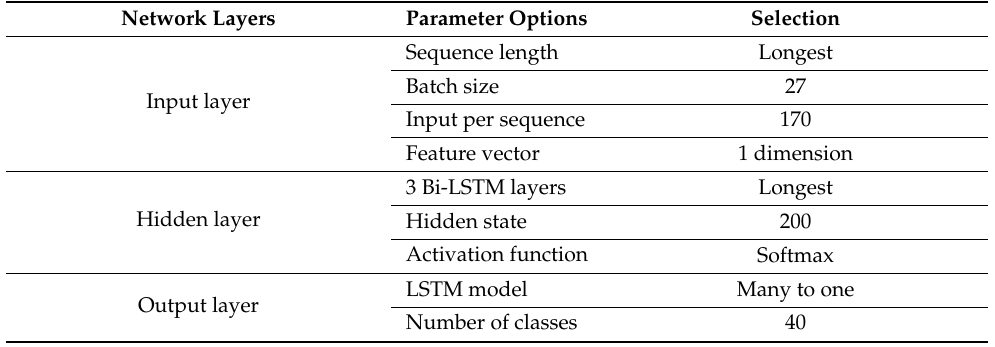
Table 4. Network parameter selection.